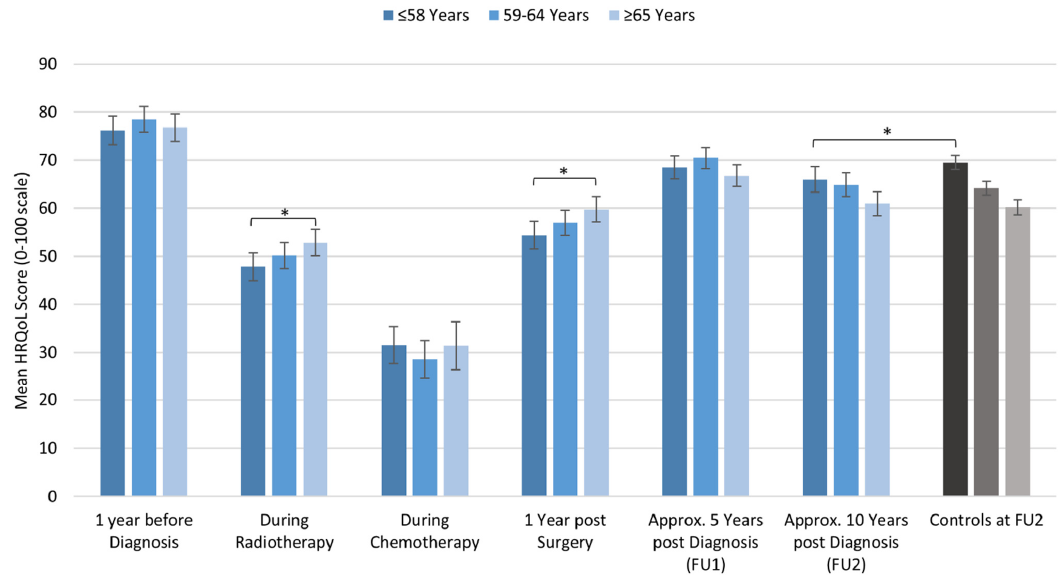
Figure 2. Longitudinal course of HRQoL in breast cancer survivors and compared to controls at approx. 10 years after diagnosis stratified by age. Significant differences are indicated by an asterisk. Table 2. HRQoL in breast cancer survivors during and after active treatment compared by age groups (1: ≤ 58 years, 2: 59- 64 years, 3: ≥ 64 years) and compared to healthy controls of the same age group 10 years after diagnosis. During During Radiation